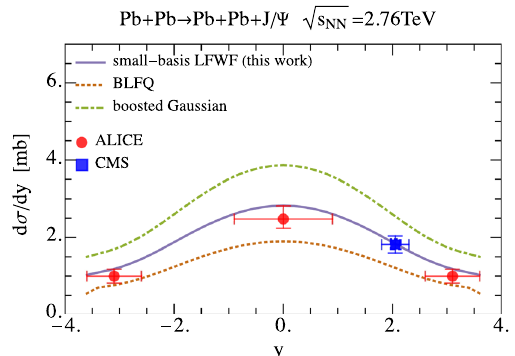
Fig. 15 Predictions of the small-basis LFWF (solid curves), the BLFQ LFWF [26] (dotted curves) and the boosted Gaussian LFWF [5] (dot- dashed curves) for the coherent production of J /ψ production in Pb–Pb √ s NN = 2 . 76TeV,comparedwiththemea- ultra-peripheralcollisionat surements by the ALICE collaboration [86,87] and CMS collaboration [88] at LHC. Error bars show statistical uncertainties